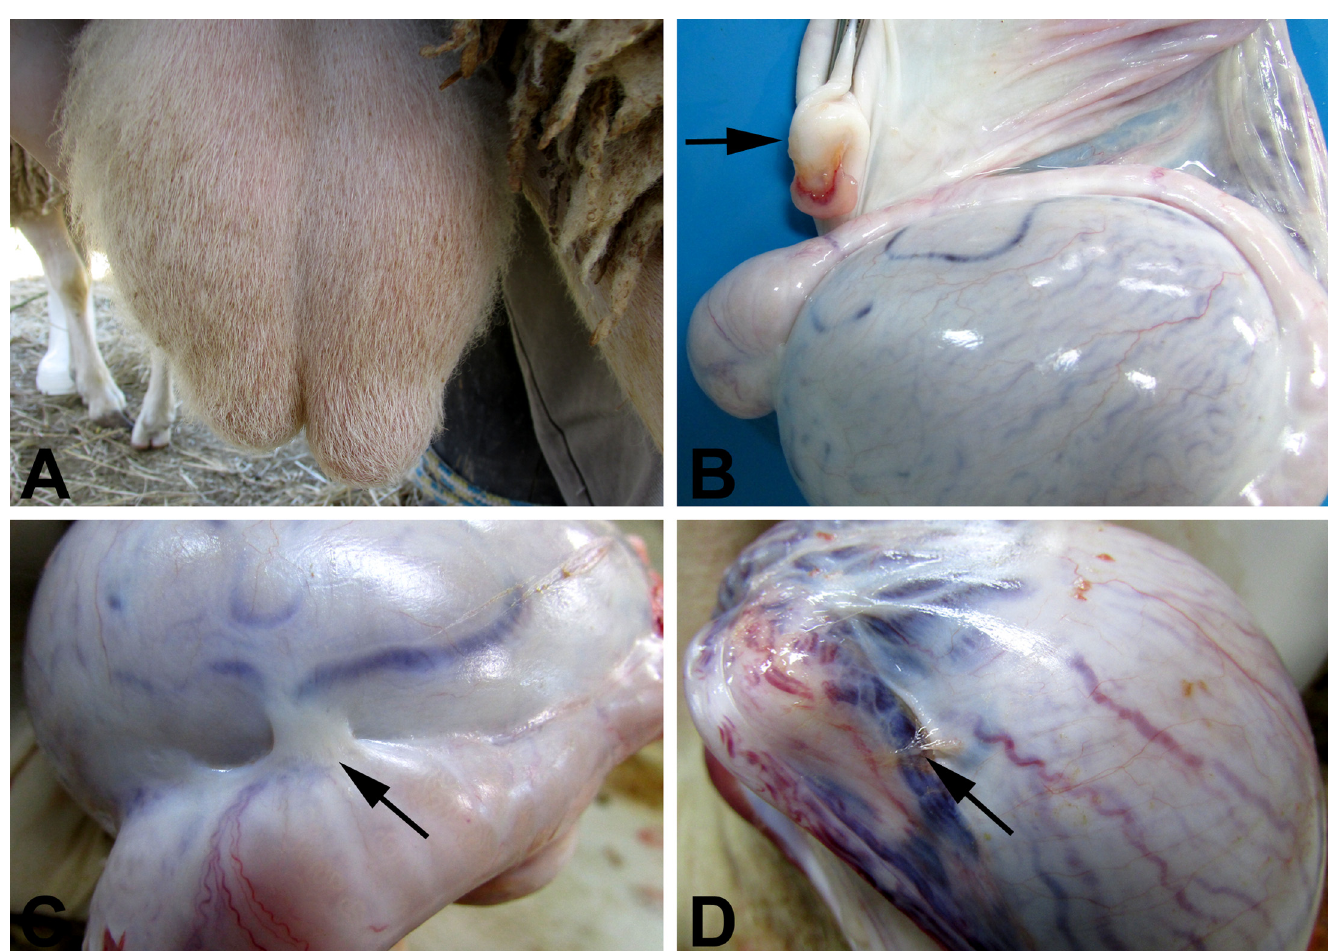
Fig 7. Gross lesions in the reproductive system of non immunized rams experimentally challenged with wild type Brucella ovis , at 8 weeks post infection. Asymmetry of the tail of the epididymis (A). Granuloma between the visceral and parietal layers of the tunica vaginalis, adjacent to the tail of the epididymis (black arrow) (B). Fibrous adhesion between testis and the head of the epididymis (black arrow) (C). Fibrinous adhesion on the tunica vaginalis (black arrow)